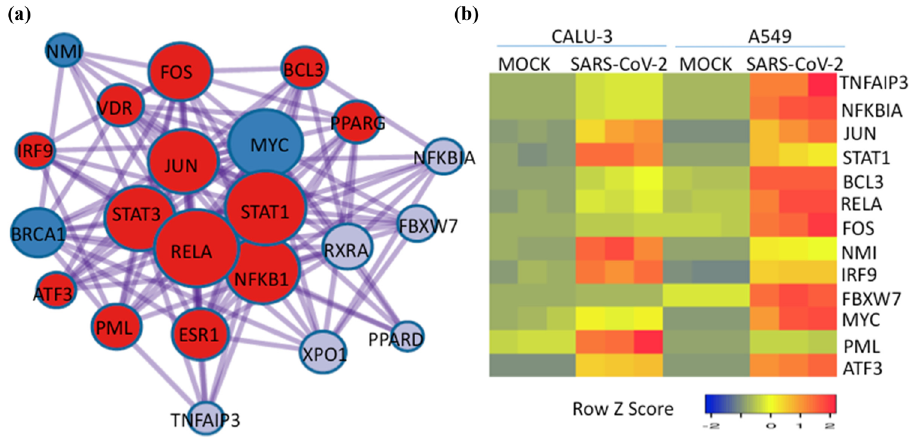
Figure 7: PIC - Venn network representation of STAT1 and other critical hubs involved in innate and adaptive immunity and transcriptional regulation by SARS - CoV - 2. ( a ) Common protein interactions of STAT1 and other critical hubs STAT3, RELA, NFKB1, FOS, and JUN revealed by PIC - VENN analysis in innate and adaptive immunity. Red, Blue, and gray colors are used to highlight di ff erent hubs in the network. ( b ) Regulation of expression of the critical hubs by SARS - CoV - 2 in the Calu - 3 and A549/ACE2 lung epithelial cell lines. Expression levels of selected hubs are shown. Low and high expression levels are represented by blue and red, respectively. RNA expression values are normalized by DEseq2 and shown as a heat map. Data from three samples for each condition are shown.